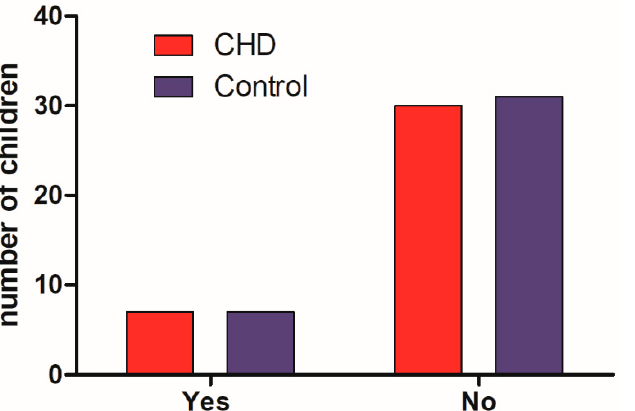
Figure 4. Children’s performance on the attention scale. “Yes” means that the child was categorized as having attention deficit and “No” refers to children without attention deficit.